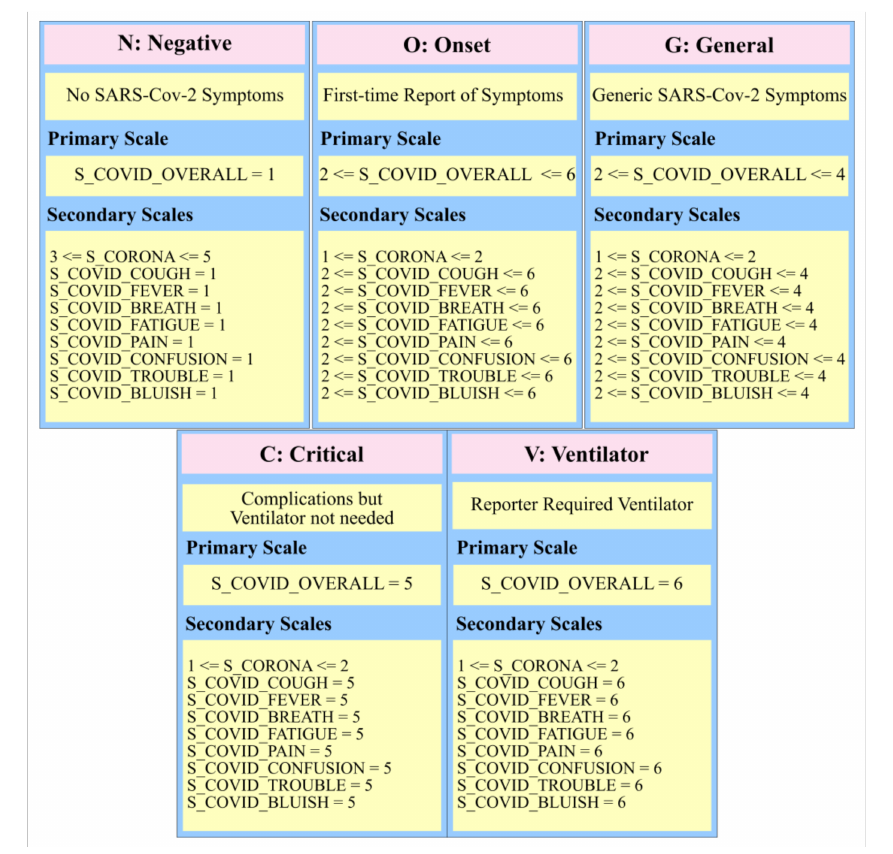
Figure 3. The reported symptoms and severities mapped to hidden Markov model (HMM)